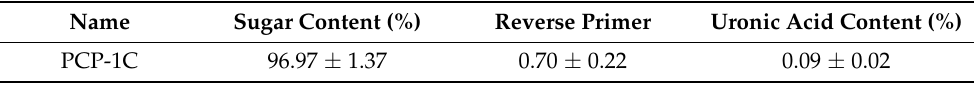
Figure 2. The appearance of PCP-1C: ( A ) the macroscopic morphology of PCP-1C; ( B , C ) SEM observation of PCP-1C using SEM at the magnification of 4000 times and 40,000 times. Table 1. Chemical compositions of PCP-1C.